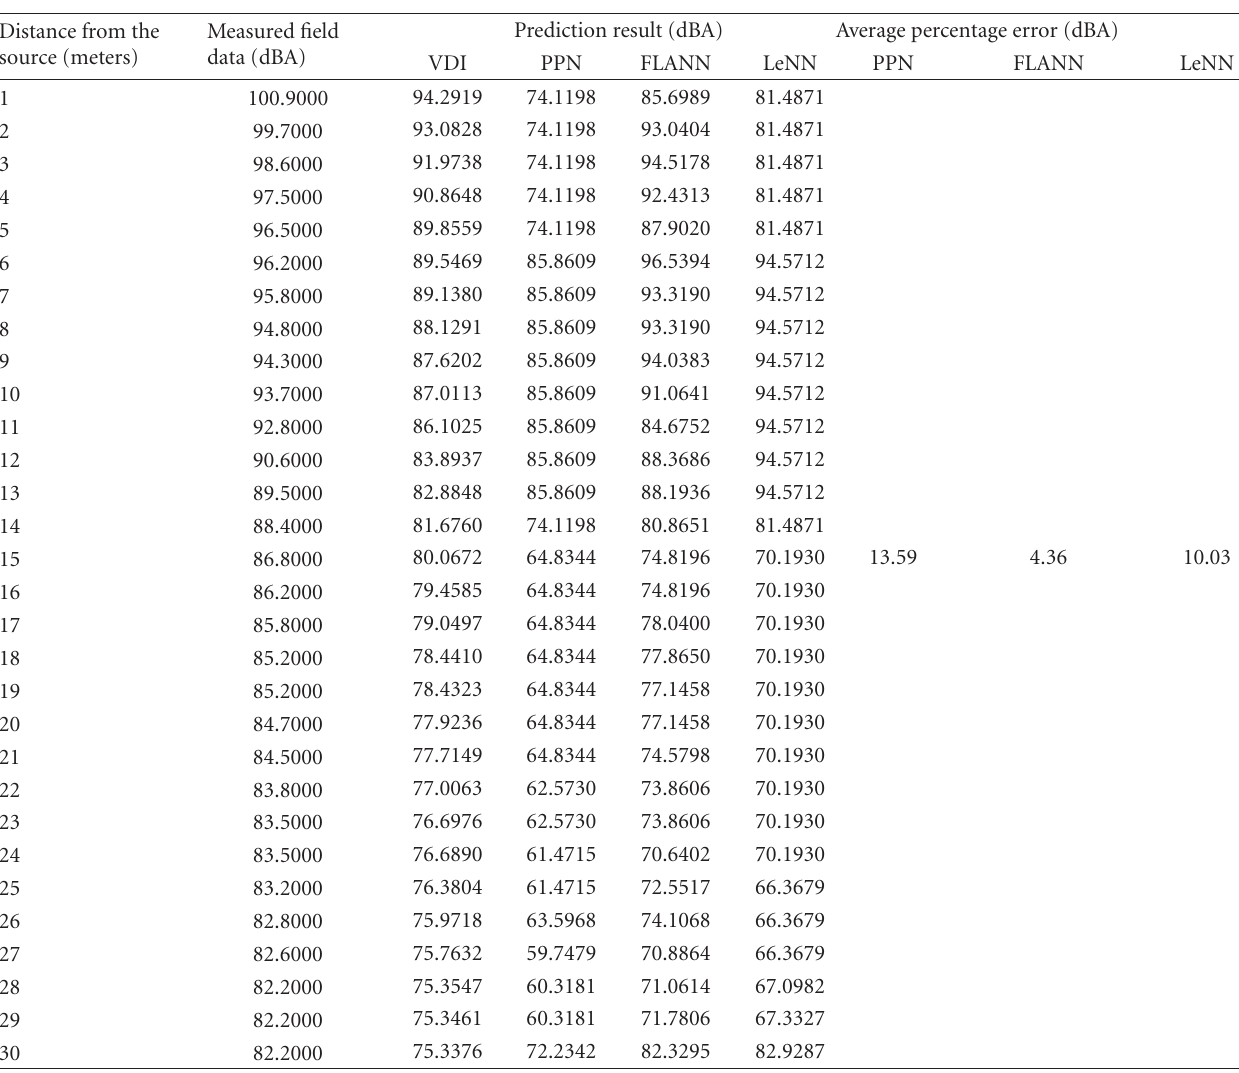
Table 4: Simulation study of tipper